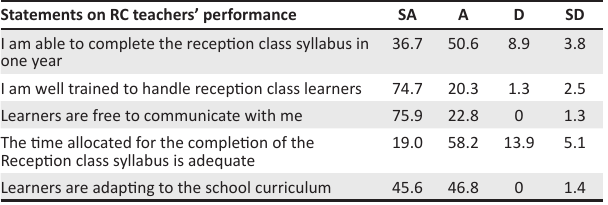
TABLE 1: Reception class teachers’ responses to statements on their performance.